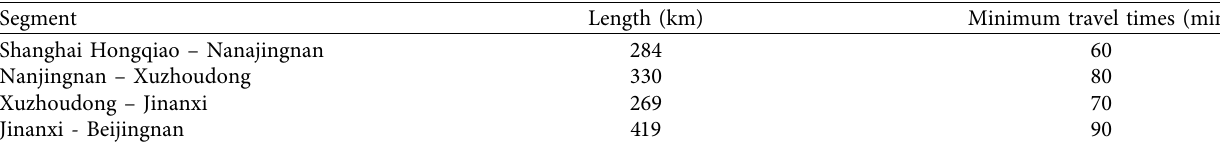
Figure 3: Map of Beijing-Shanghai high-speed railway corridor. Table 3: Length and minimum travel time of the train on each